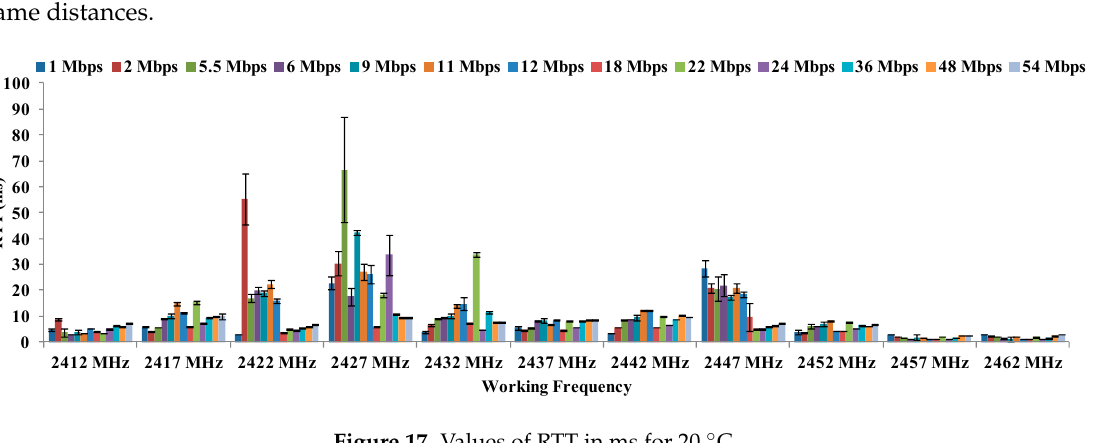
Figure 17. Values of RTT in ms for 20 °C.